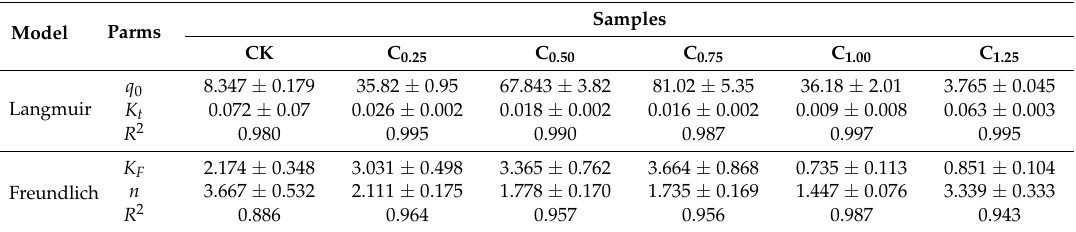
Table 3. The parameters of the Langmuir and Freundlich adsorption models for Cd (II).